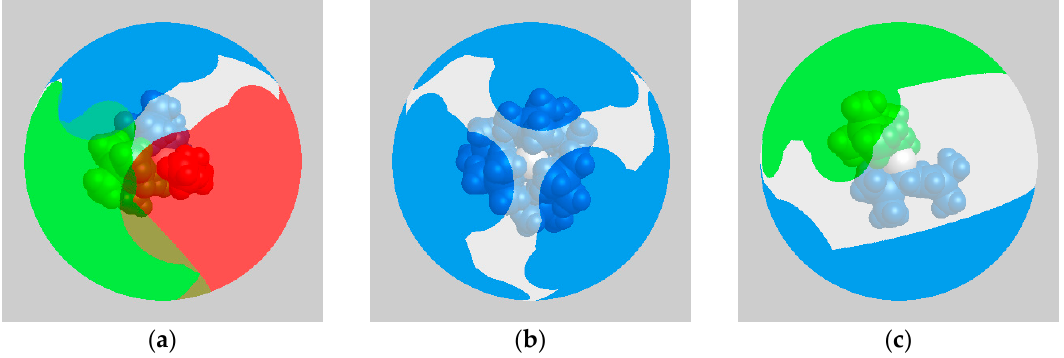
Figure 5. Visualization of the extent of coordination sphere coverage (G complex ) of: ( a ) BeA’ 2 ·Et 2 O (the coverage from the two allyls are assigned blue and green; that from the ether is in red); ( b ) 1 (all three allyls are in blue); and ( c ) BeA’ 2 , using optimized coordinates (APF-D/6-311G(2d) (Be); 6-31G(d) (other atoms)) and the program Solid-G [28]. The G complex value takes into account the net coverage; regions of the coordination sphere where the projections of the ligands overlap are counted only once.